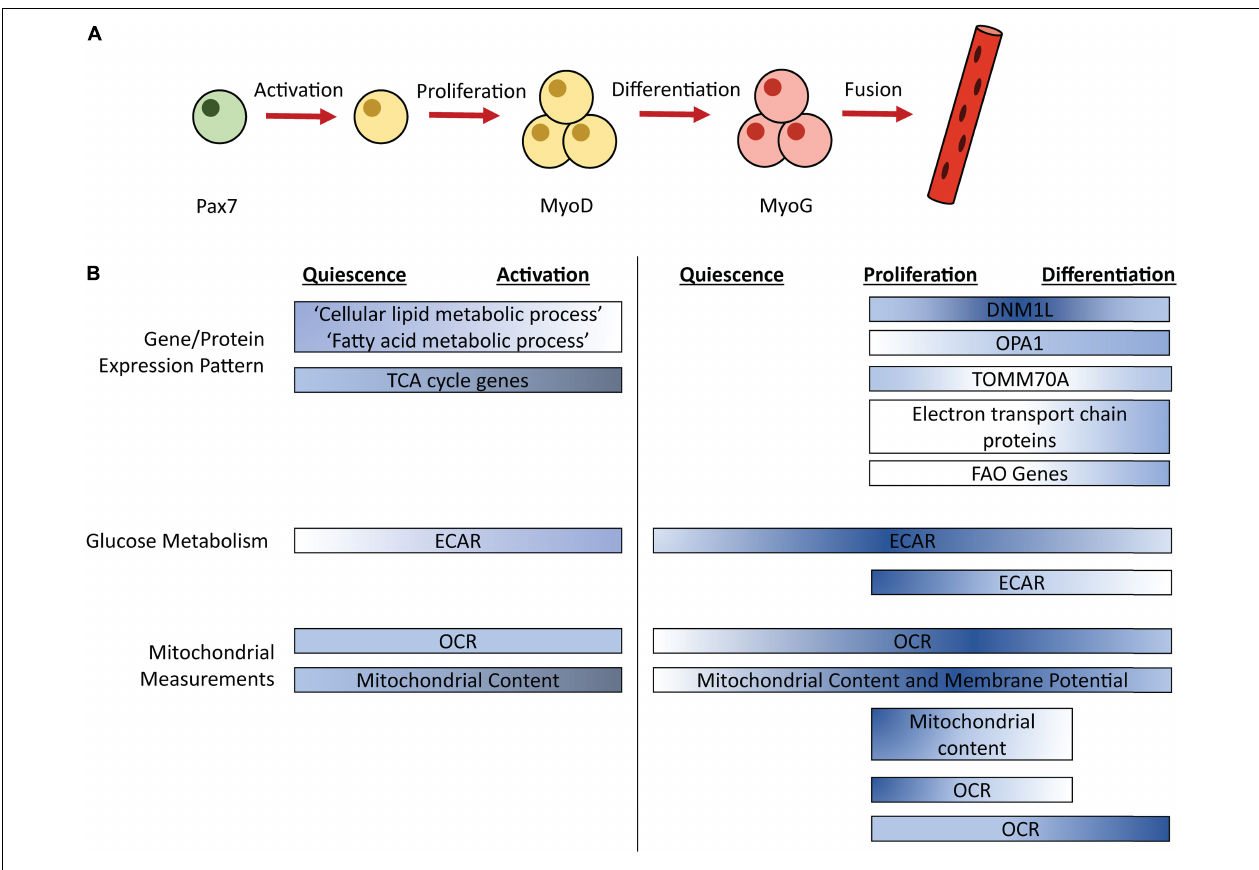
FIGURE 1 | Simplified schematic of the myogenic process (A) with timing of metabolic pathways (B) . Color corresponds to relative pathway use; darker color indicates more intense relative pathway use. Comparisons are made within each bar, not between bars. ECAR, Extracellular acidification rate; OCR, Oxygen consumption rate; FAO, Fatty acid oxidation; Pax7, paired box 7; MyoD, Myoblast determination protein 1; MyoG, Myogenin.